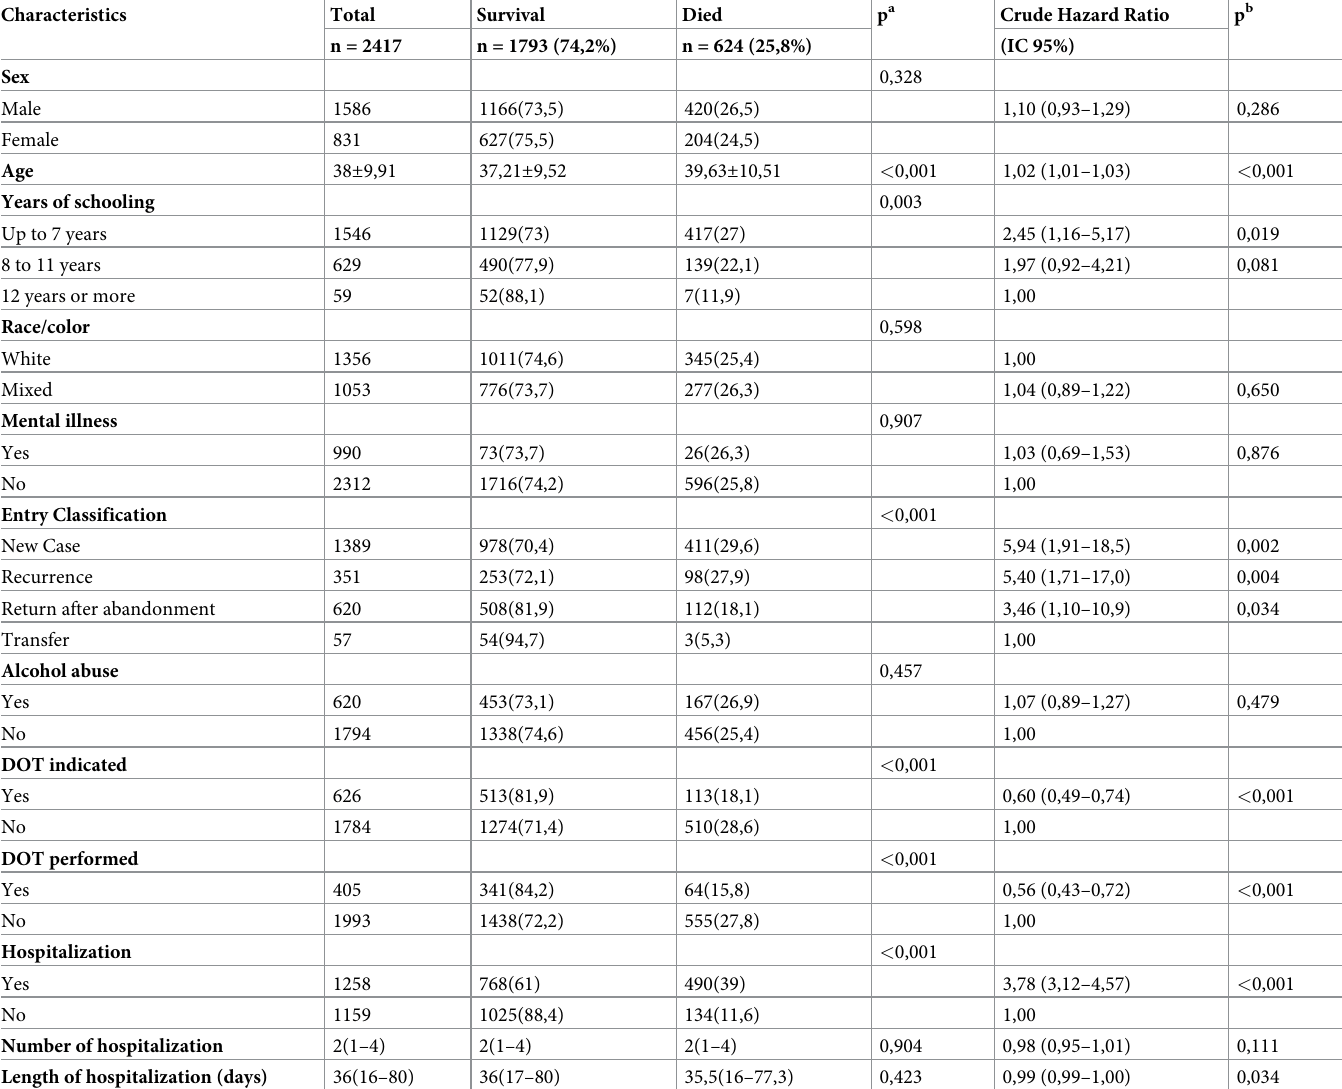
Table 1. Sociodemographic and clinical characteristics associated with death in cases of TB/HIV coinfection, 2009–2013, Porto Alegre, Brazil.